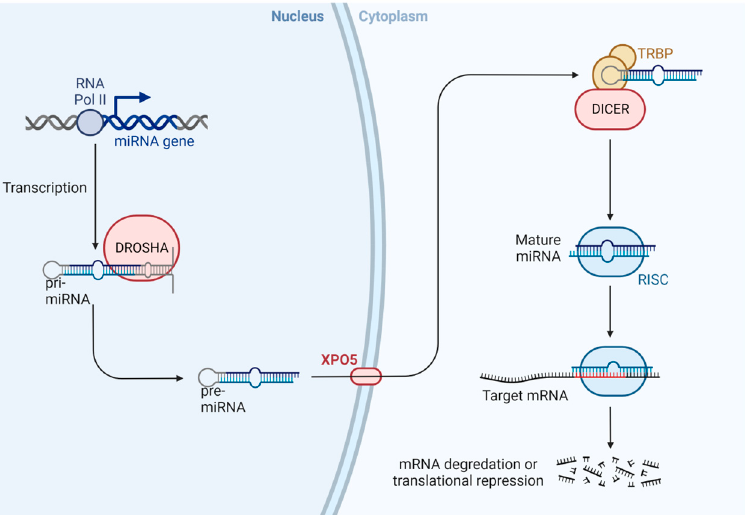
Figure 5. Scheme of miRNA biogenesis. In the nucleus, miRNA is transcribed by RNA polymerase II as primary transcripts (pri-miRNA). The Drosha enzyme cuts this pri-miRNA to form a pre- miRNA, which is actively transported to the cytoplasm by the nuclear transport receptor exportin 5 (XPO5). In the cytoplasm, the pre-miRNA is cut by a second enzyme, Dicer, to form a mature and short double-stranded miRNA molecule. The miRNA duplex is incorporated into the RISC protein complex [92].